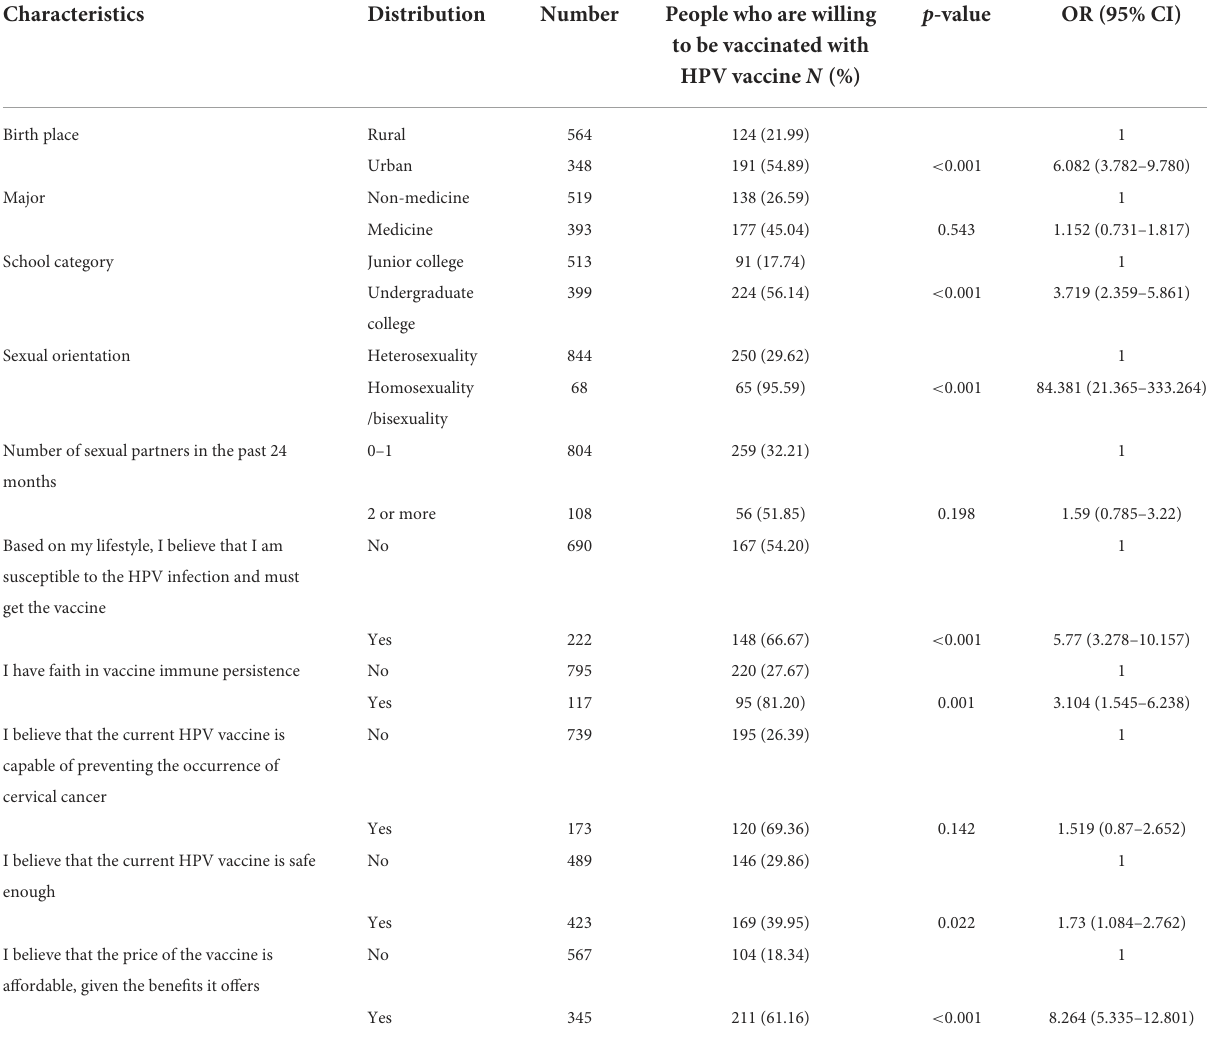
TABLE 4 Logistic multivariate analysis of HPV vacci nation willingness among male college students in Nanjing, China.